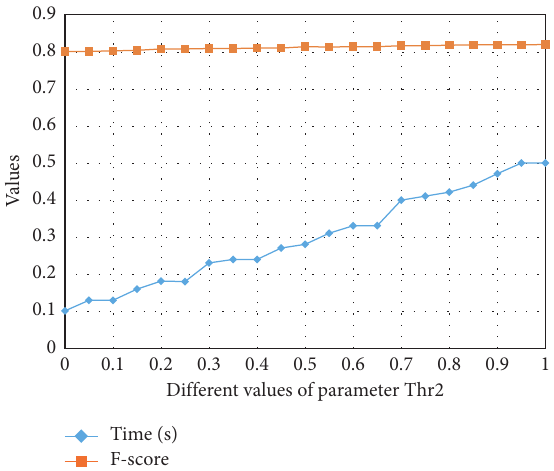
Figure 5: The experimental results of performance index F-score and running time when the value of Thr2 is different.